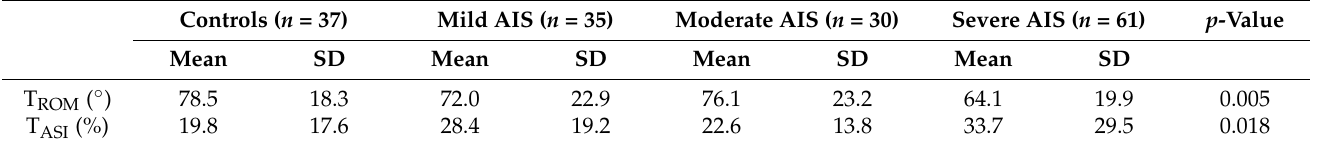
Table 3. T ROM and T ASI of mild, moderate, and severe AIS patients and controls with ANOVA p -value.